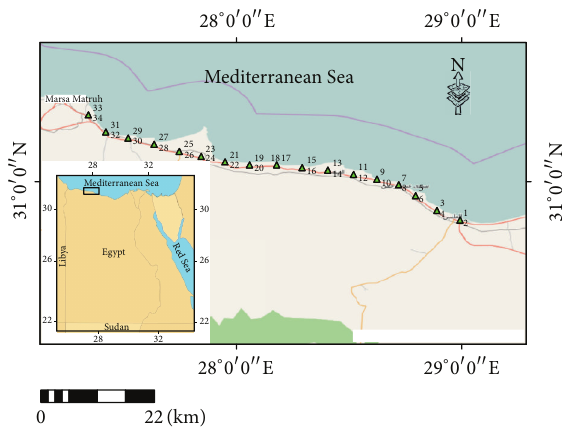
Figure 1: Location map for sampling